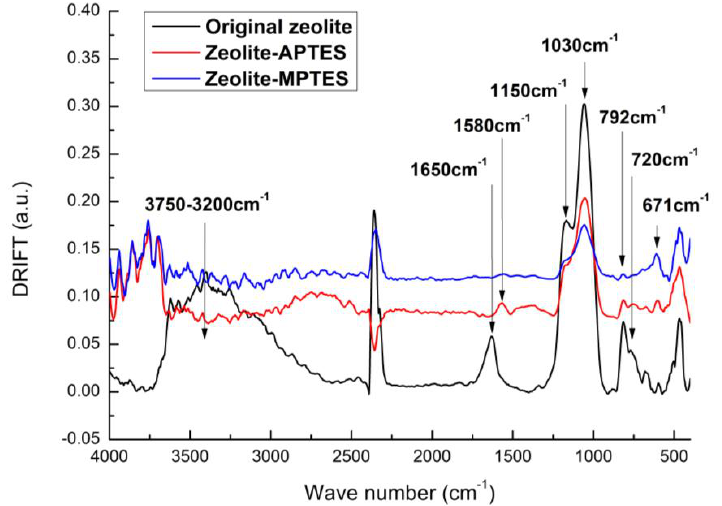
Figure 1. DRIFT spectra of zeolite before and after deposited with APTES or MPTES.